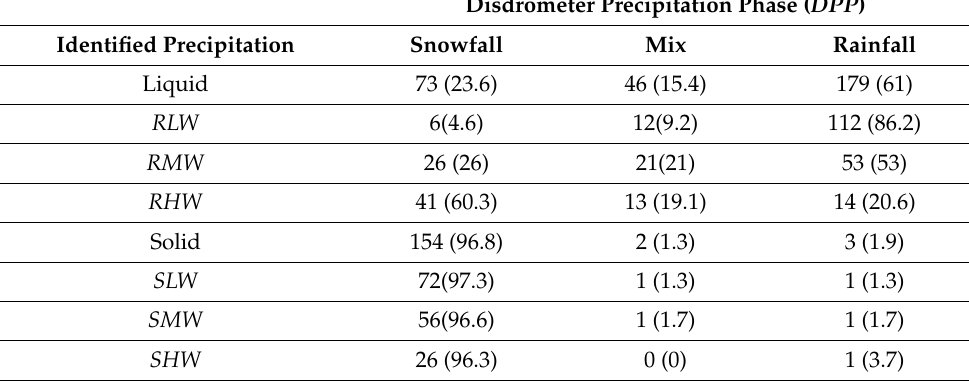
Table 5. Comparison between the precipitation phase measured by the disdrometer ( DPP ) and the classified precipitation in this study. The percentages of contribution of each subgroup ( LW, MW, HW ) regarding liquid and solid precipitation are shown in parenthesis.